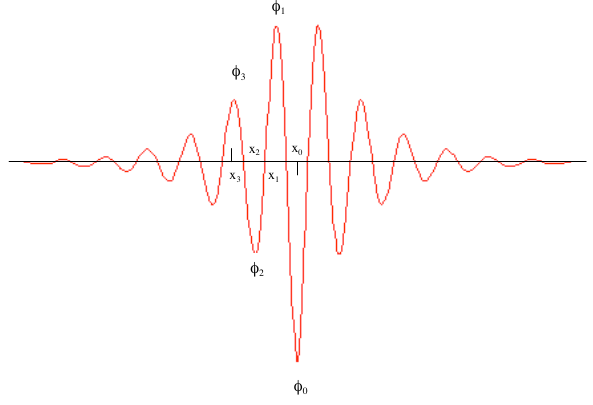
Figure 1: A symmetric wave Packet illustration with maxima and minima. Fig. 1. A symmetric wave Packet illustration with maxima and min-